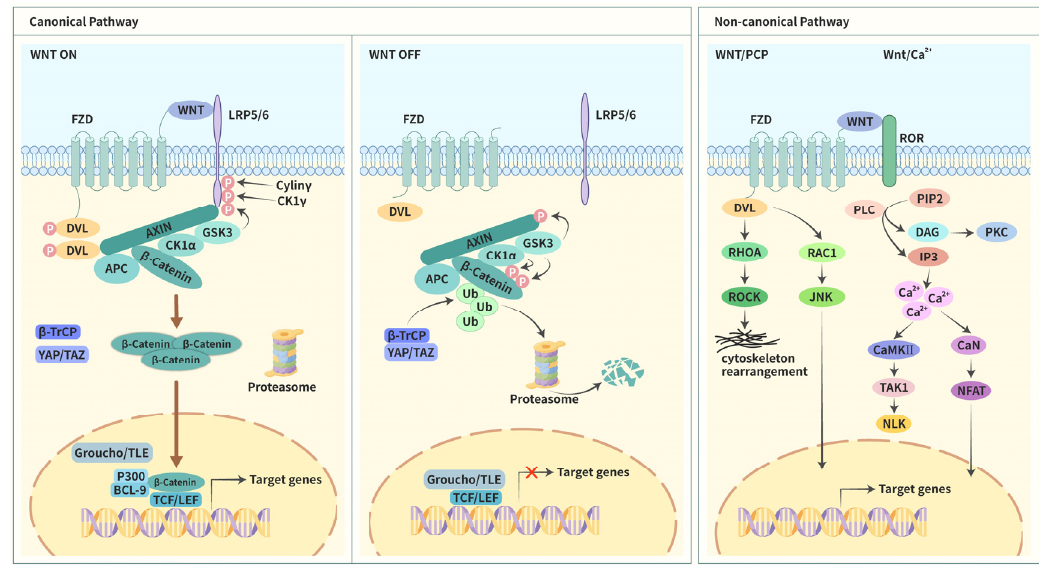
Figure 1. Schematic interpretation of canonical and noncanonical Wnt pathway.